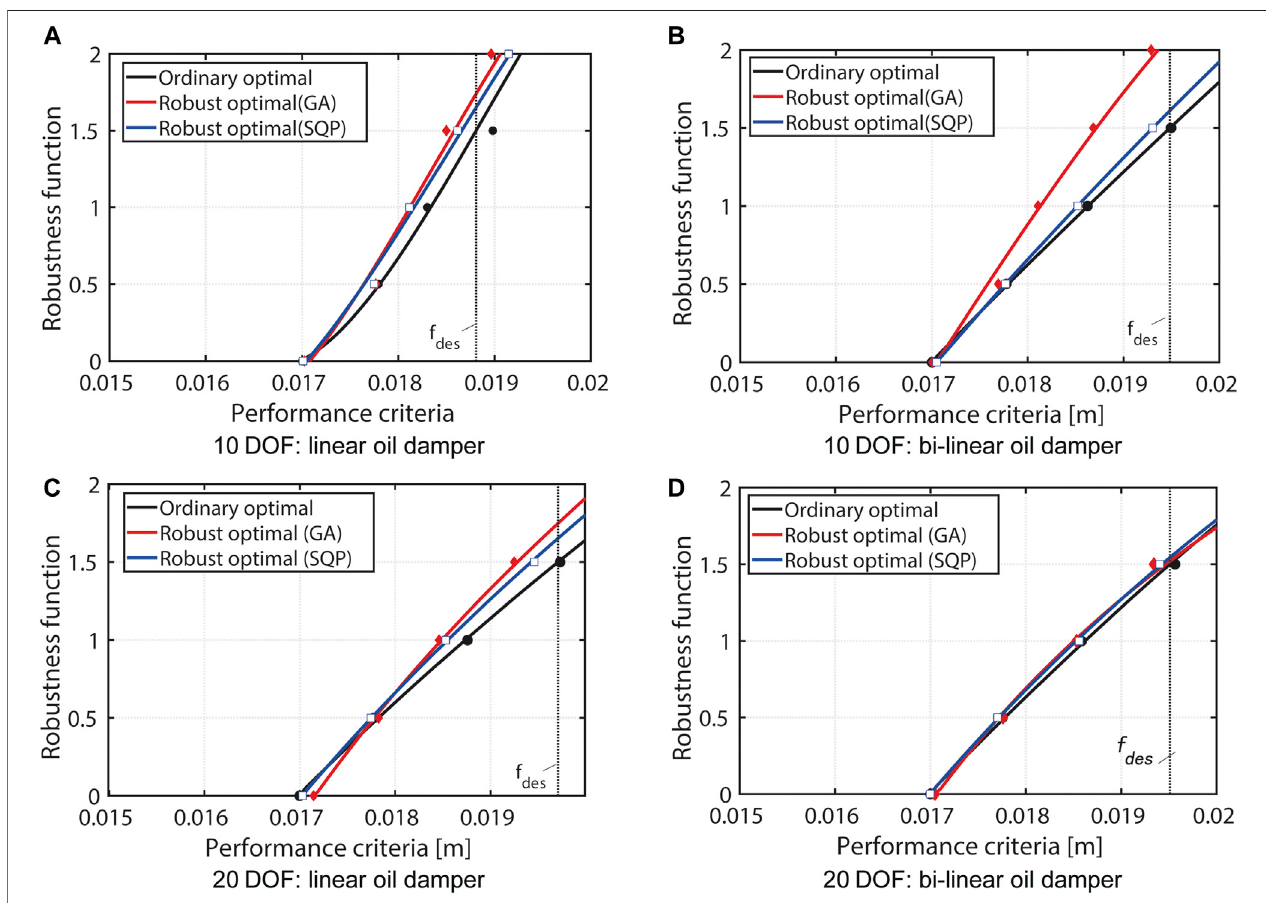
FIGURE 12 | Comparison of robustness functions for robust optimal damper placement with that for ordinary optimal damper placement.